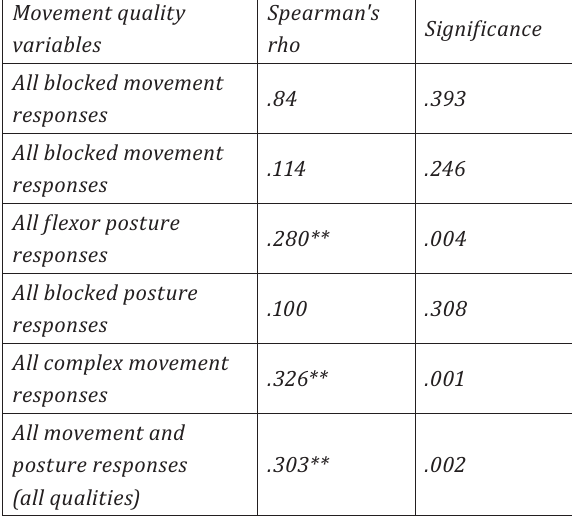
Table 7. The values of Spearman’s rho between the “chiaroscuro” variable and movement quality variables in the group of all parents (N =